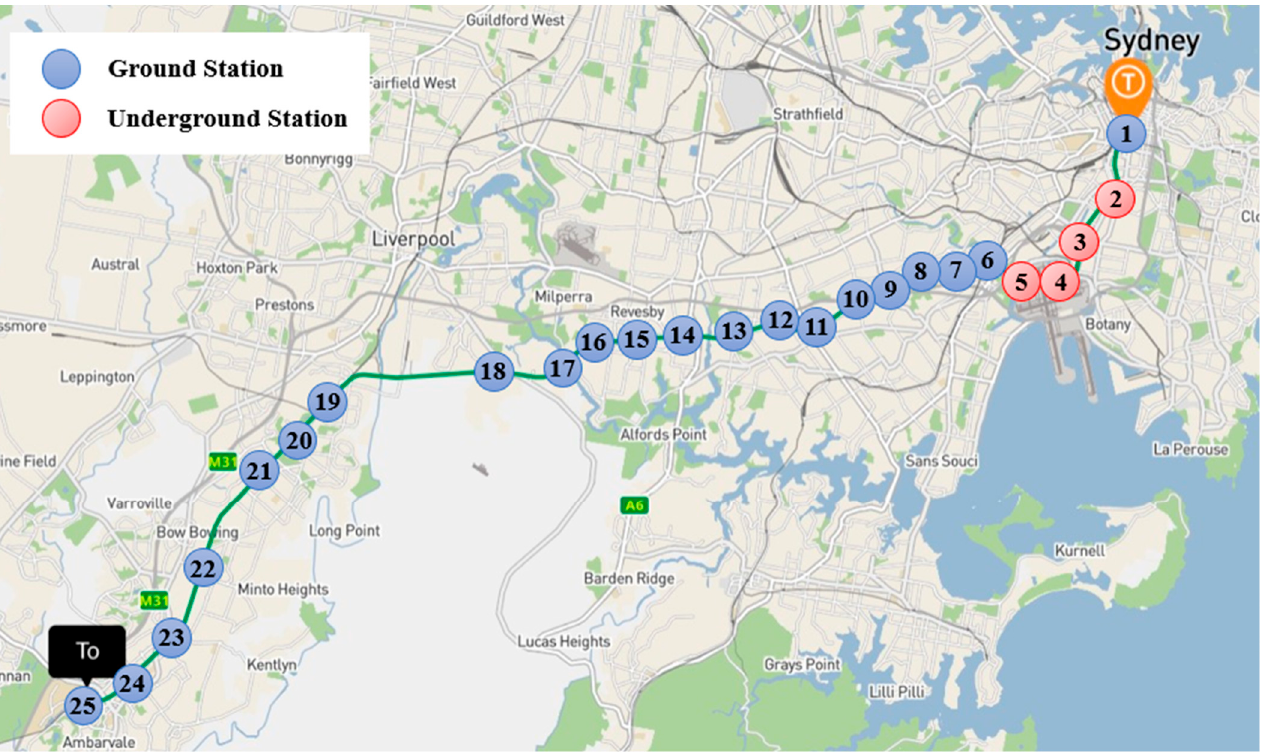
Figure 2. Map of the T8 line from Central Station to Macarthur Station: 1. Central Station, 2. Green Square Station, 3. Mascot Station, 4. Sydney Domestic Airport Station, 5. Sydney International Airport Station, 6. Wolli Creek Station, 7. Turrella Station, 8. Bardwell Park Station, 9. Bexley North Station, 10. Kingsgrove Station, 11. Beverly Hills Station, 12. Narwee Station, 13. Riverwood Station, 14. Padstow Station, 15. Revesby Station, 16. Panania Station, 17. East Hills Station, 18. Holsworthy Station, 19. Glenfield Station, 20. Macquarie Fields Station, 21. Ingleburn Station, 22. Minto Station, 23. Leumeah Station, 24. Campbelltown Station, and 25. Macarthur